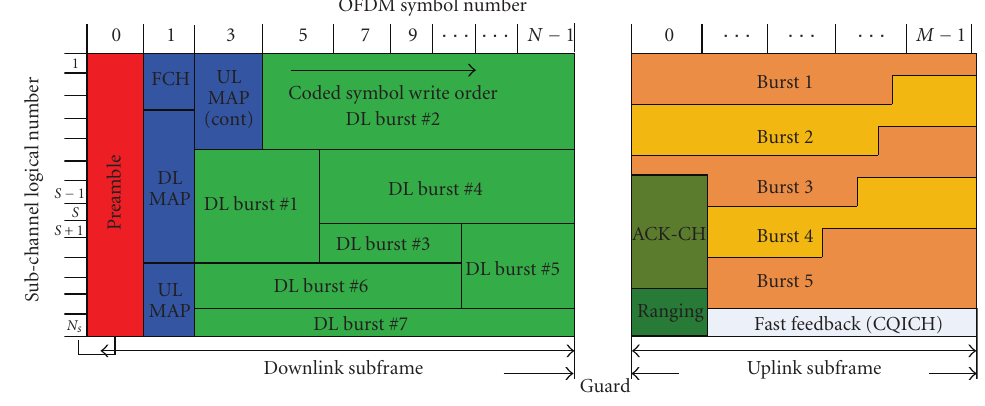
Figure 5: WIMAX frame